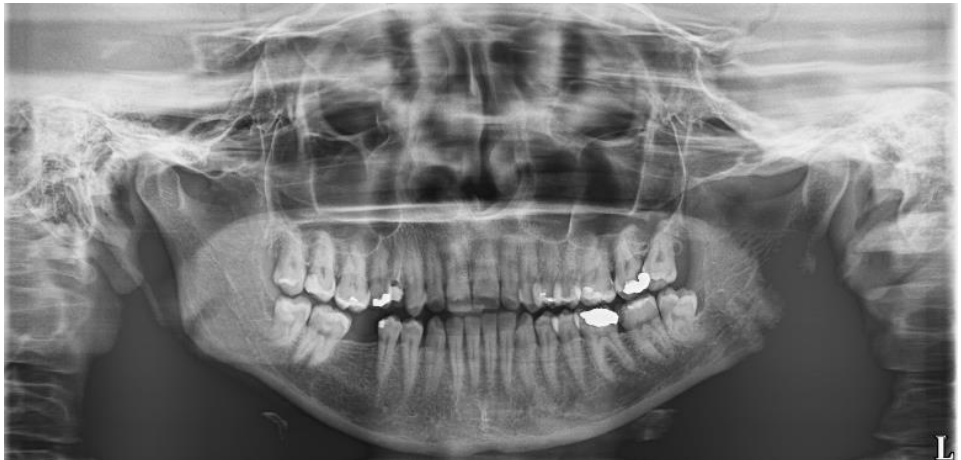
Figure 3. The orthopantomogram of the patient 2. Tooth No. 38 is in normal position, slightly distally inclined, with a semilunar burnout distally. The OPG was not taken at our department. Two days after the extraction, she started to feel pain in the extraction wound. Three